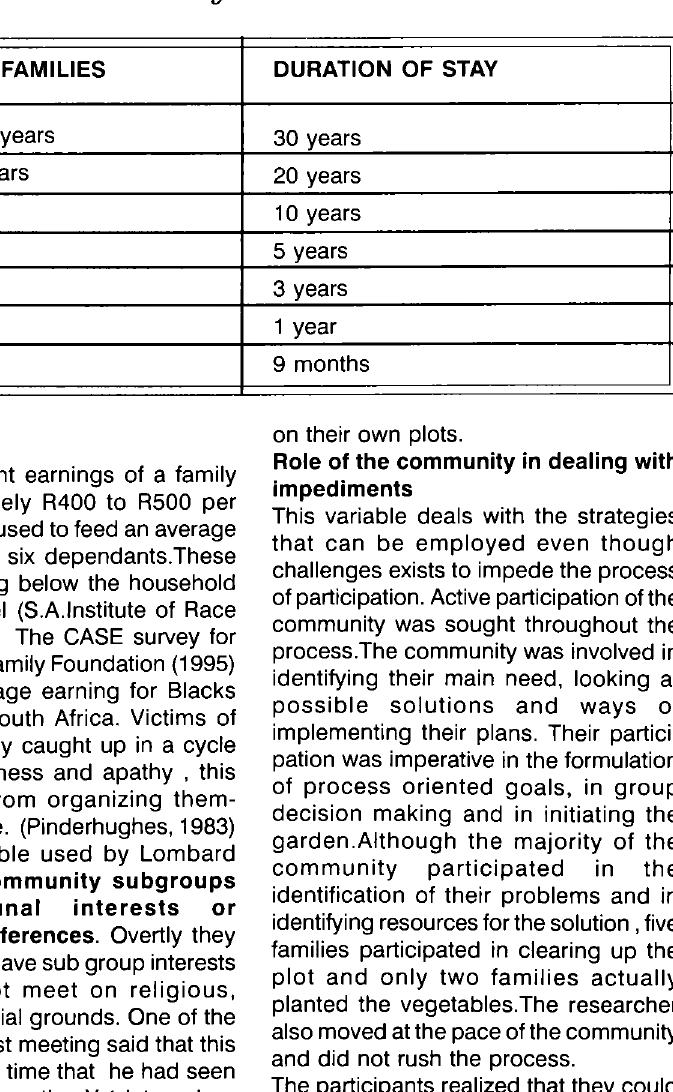
Table 2 : Duration of stay in Gravesend farm